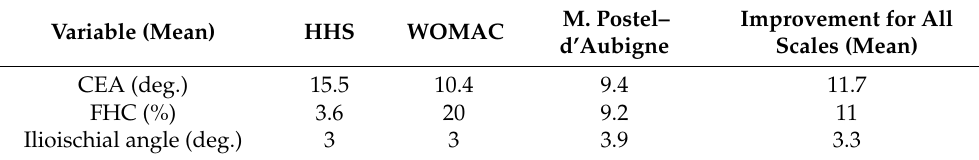
Table 3. The results of the desired hip correction according to the parameters of CEA, FHC, and ilioischial angle based on the ROC curve on obtaining a “better” score of the clinical scales HHS, WOMAC, and M. Postel–d’Aubigne.